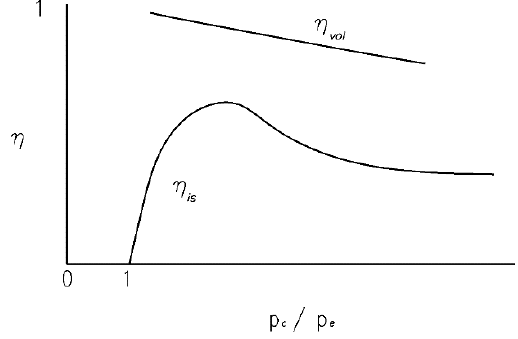
Figure 8. The efficiency principle curves η is and η vol of a scroll